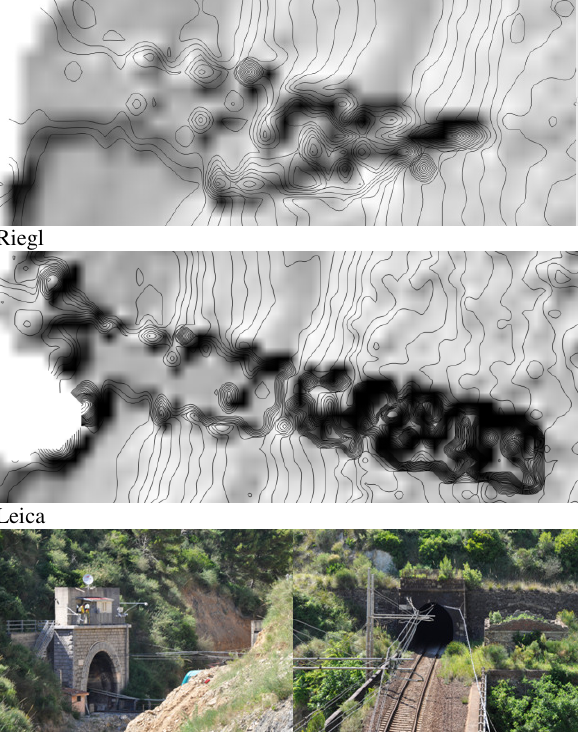
Figure 12. An unexplained effect